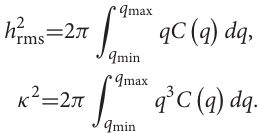
Frontiers in Mechanical Engineering |